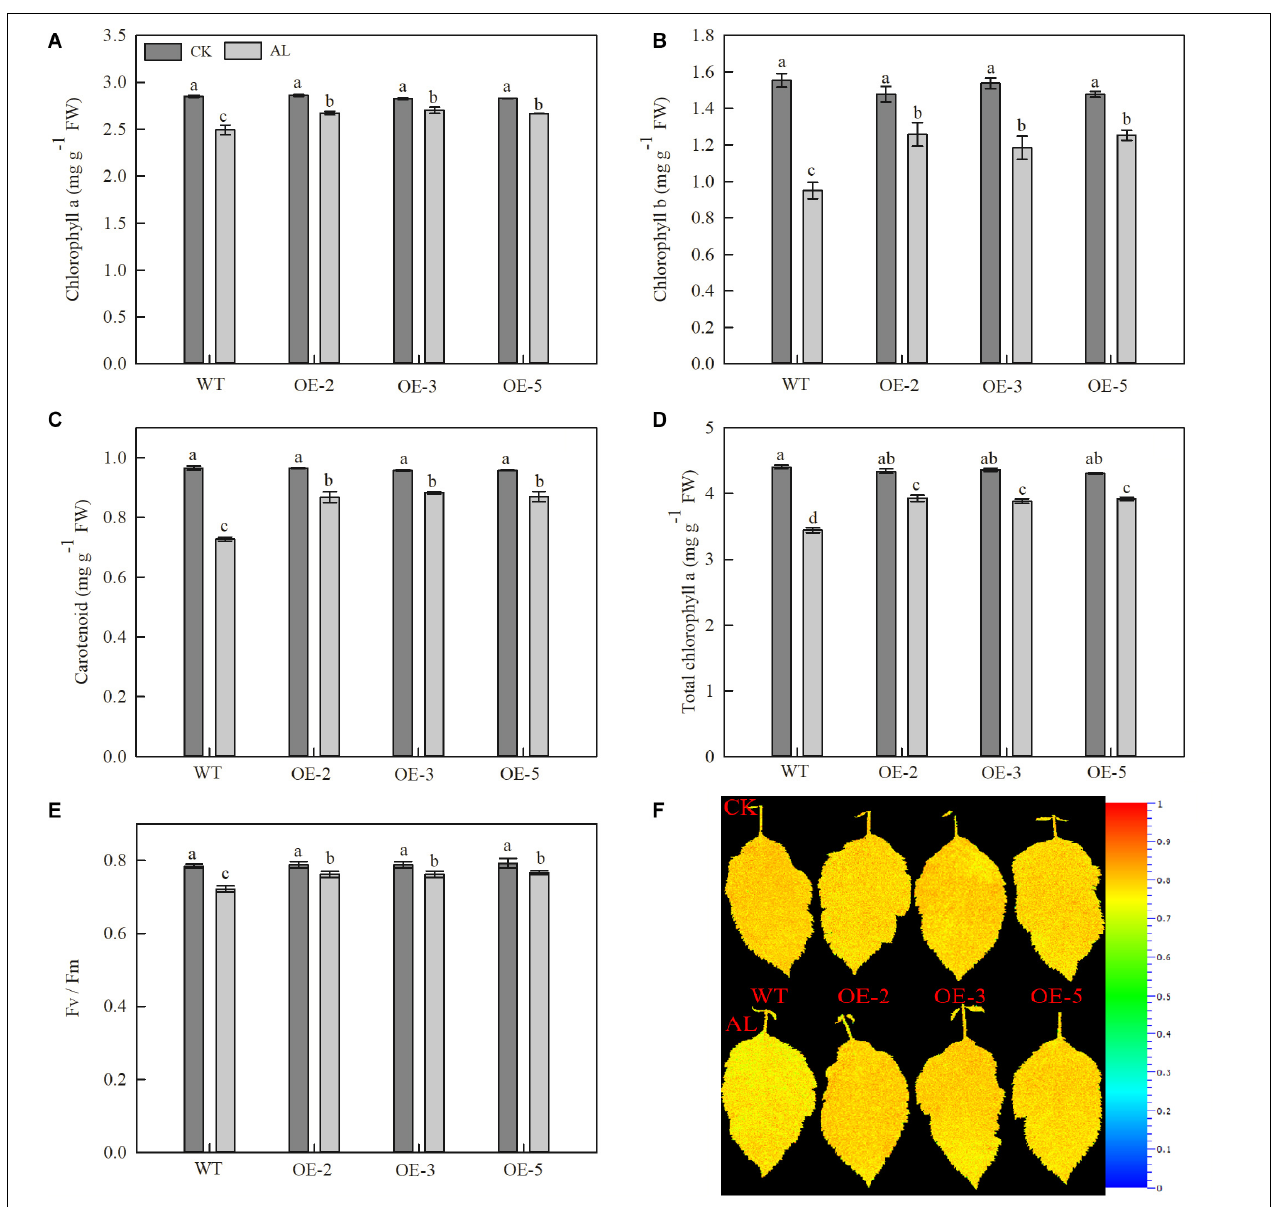
FIGURE 4 | Overexpression of MdTyDc enhanced the chlorophyll concentrations and Fv/Fm after 15 days under control and alkaline conditions. (A) Chlorophyll a, (B) chlorophyll b, (C) carotenoids, (D) total chlorophyll, (E) Fv/Fm, and (F) Fv/Fm image obtained from chlorophyll fluorescence imaging. The data are presented as means ± SD ( n = 5). Significant differences between WT and MdTyDc overexpression lines are indicated by different lowercase letters based on Tukey’s multi-range test ( P < 0.05). WT, wild type. OE-2, MdTyDc overexpression line 2. OE-3, MdTyDc overexpression line 3. OE-5, MdTyDc overexpression line